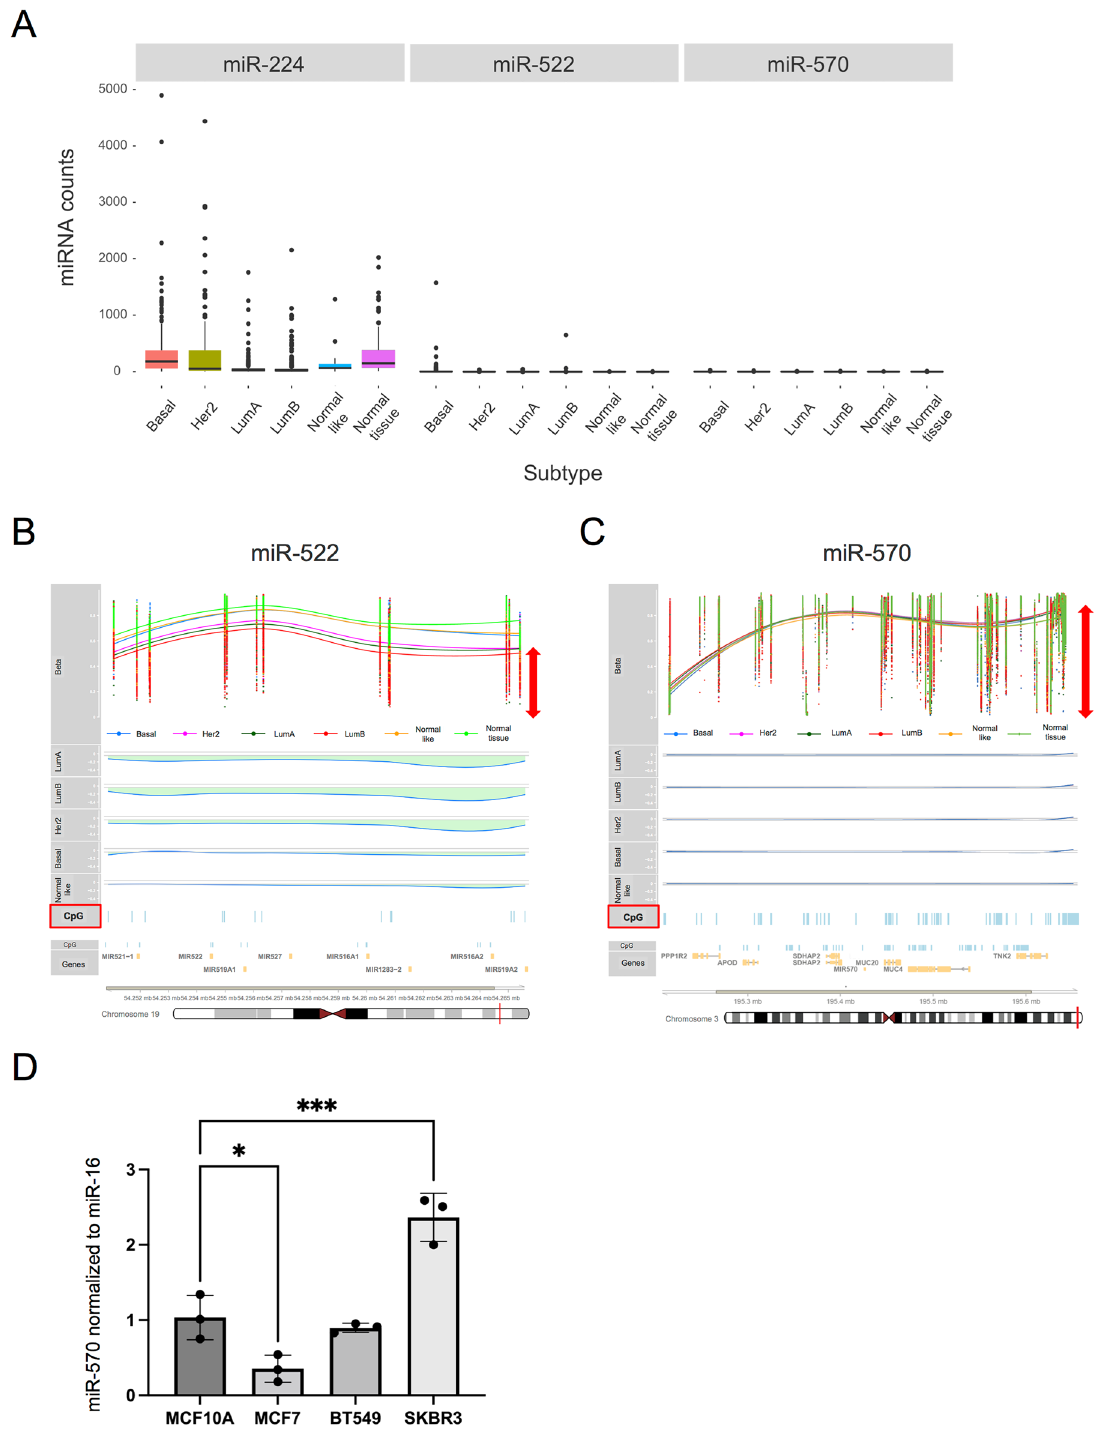
Figure 3. Gene expression and methylation status of three candidate miRNAs gene in breast tissue. ( A ) The total expression levels of the three miRNAs in the breast cancer cohort were evaluated by comparing their expression between the normal tissue and the different subtypes of tumor tissue for the candidate miRNAs. ( B ) Methylation status of the hsa-miR-522 gene in breast tumor samples. "Beta" lane shows the methylation values (Beta values) which range from 0 to 1 and are shown on the vertical axis (y-axis), while each column of dots represents a particular CpG site, located in relation to its chromosomal region (red line on the chromosome diagram at the bottom). Each point represents an individual sample and the methylation value measured for the corresponding CpG site. In the beta value lane, a smoothed regression curve was added to the scatter plot to show the methylation differences between mammary cancer subtypes and normal tissue. The lanes below show the ’bumps’ for each tumor subtype, representing the levels of methylation in each region as a whole. ( C ) Methylation status of the hsa-miR-570 gene in breast tumor samples. ( D ) miR-570 expression in MCF10A and breast cancer cell lines was evaluated through real-time PCR. Representative image of three individual experiments with three replicates (n = 3; *p < 0.05, ***p < 0.001, one-way ANOVA followed by post hoc Turkey’s test, error bars =